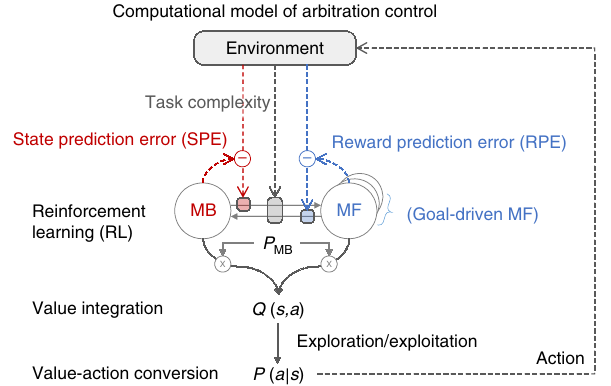
Fig. 4 Computational model of arbitration control incorporating uncertainty and complexity. The circle-and-arrow illustration depicts a two-state dynamic transition model, in which the current state depends on the previous state (an endogenous variable) and input from the environment (exogenous variables). The environmental input includes the state-transition which elicits state-prediction errors (SPEs), rewards that elicit reward-prediction error (RPEs), and the task complexity. The arrow refers to the transition rate from MB to MF RL or vice versa, which is a function of SPE, RPE, and task complexity. The circle refers to the state, de fi ned as the probability of choosing MB RL ( P MB ). Q(s,a) refers to the values of the currently available actions ( a ) in the current state ( s ). The value is then translated into action, indicated by the action choice probability P(a|s)